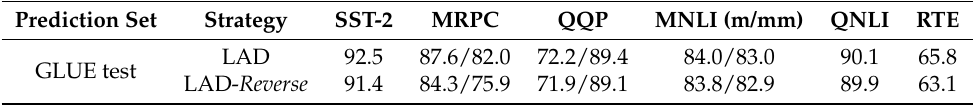
Table 5. Analysis of the propagation direction of the Gate Network. LAD 6 - Reverse indicates that we reversed the direction in the Gate Network during knowledge distillation.